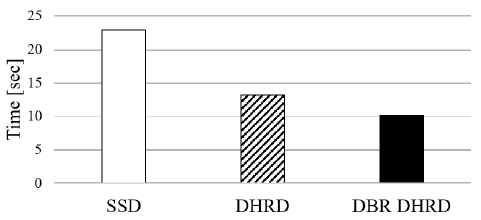
Figure 12. A result of reading and writing for video